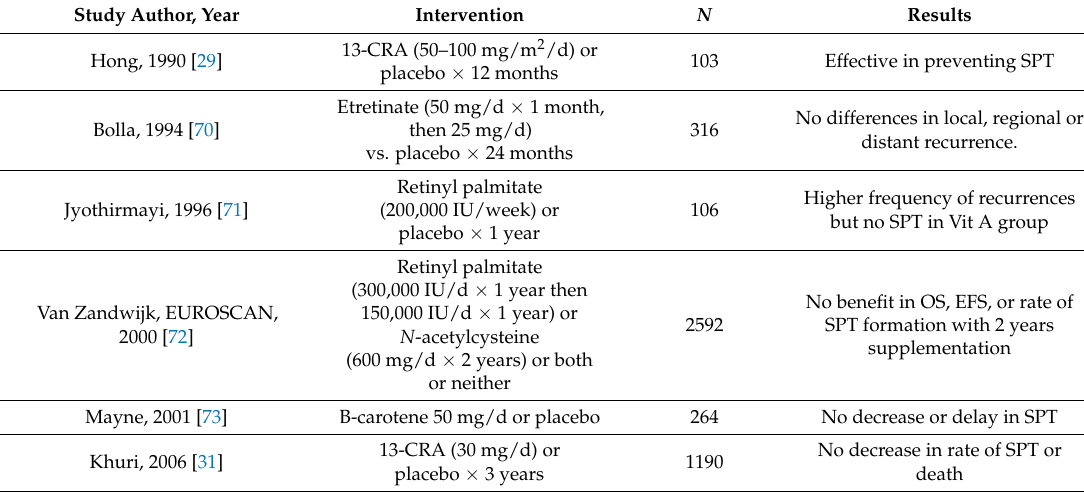
Table 2. Randomized controlled chemoprevention trials of SCCHN second primary tumors (SPTs).